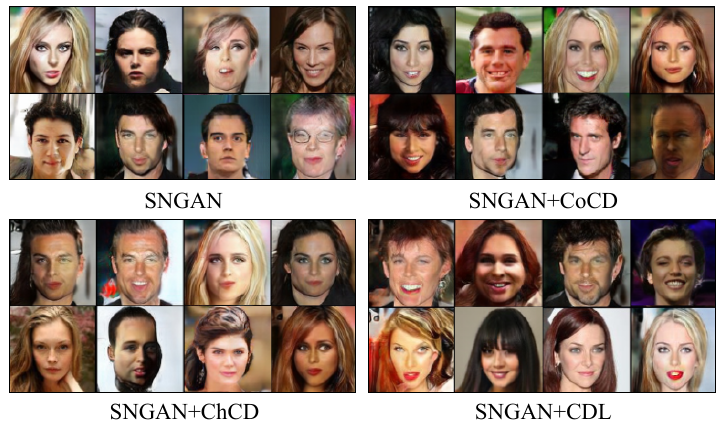
Figure 9. Image samples from SNGAN, SNGAN + CoCD, SNGAN + ChCD, and SNGAN + CDL on